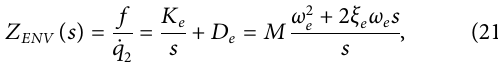
Frontiers in Robotics and AI |